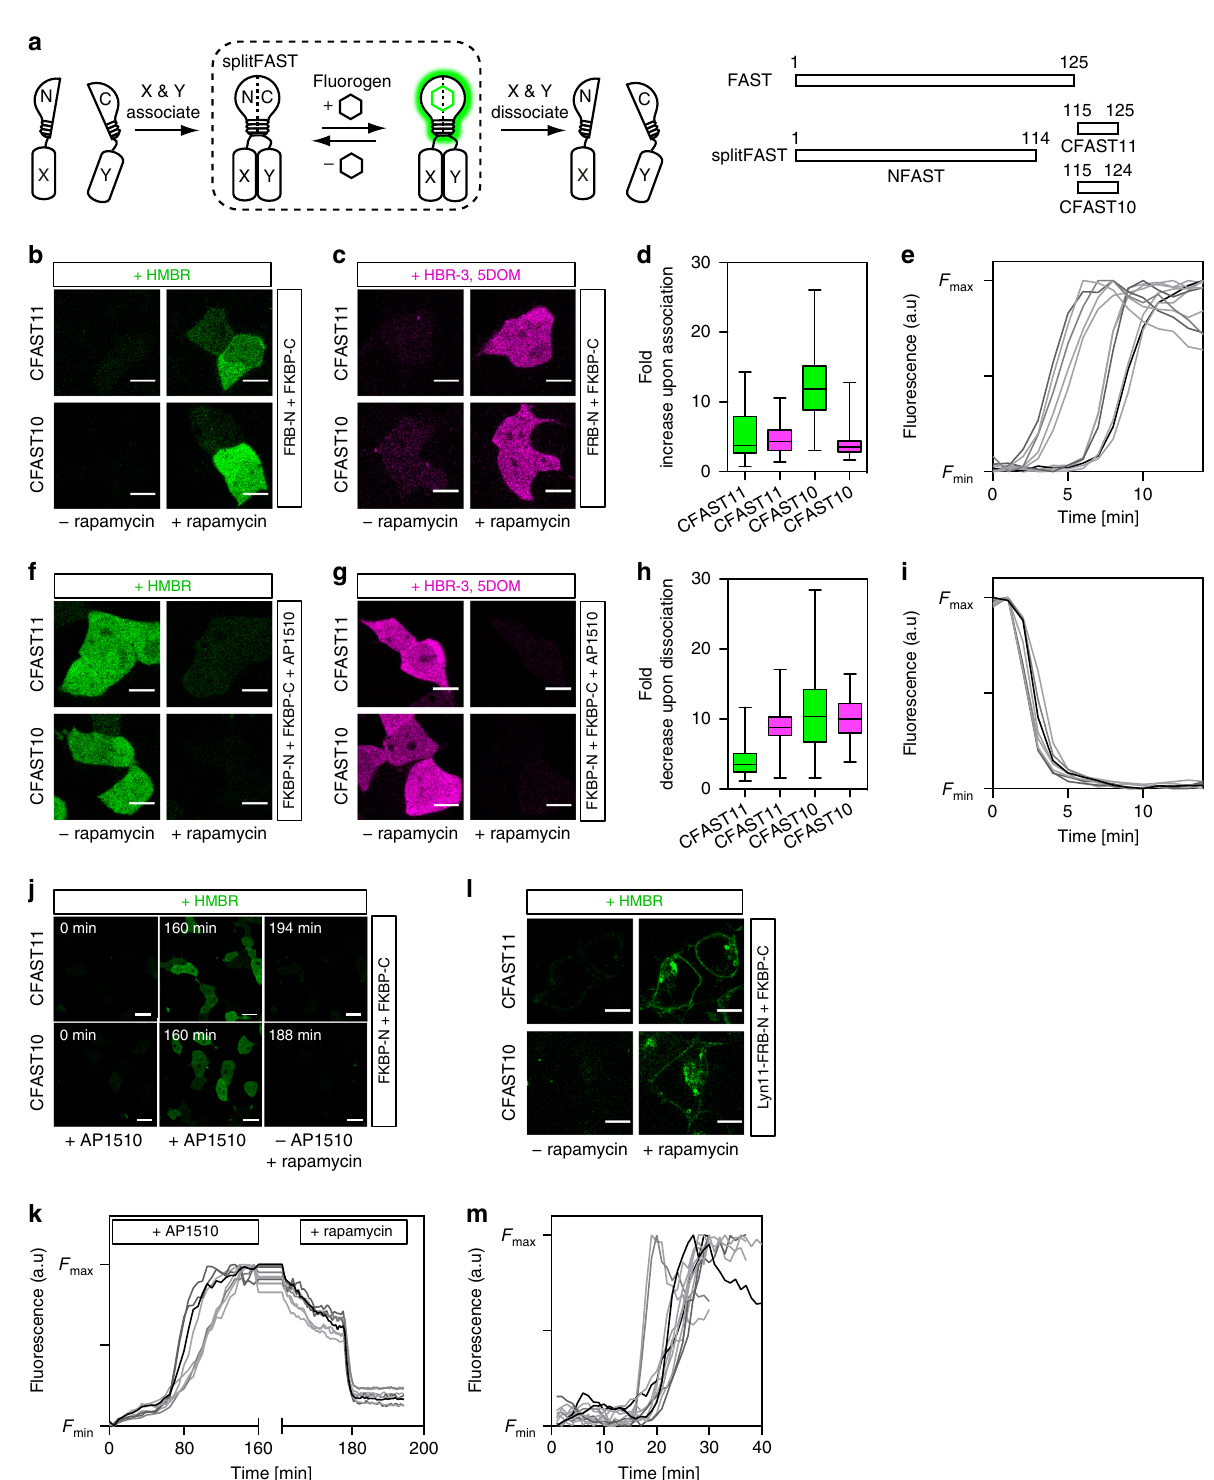
(Fig. 1l, m and Supplementary Fig. 7), demonstrating its ability to sense PPIs at the plasma membrane in real time. Detection of interactions from the MAPK signaling pathway . We then benchmarked splitFAST with known, physiologically relevant PPIs from the mitogen-activated protein kinase (MAPK) signaling pathway. NFAST was fused to K-Ras, a small GTPase